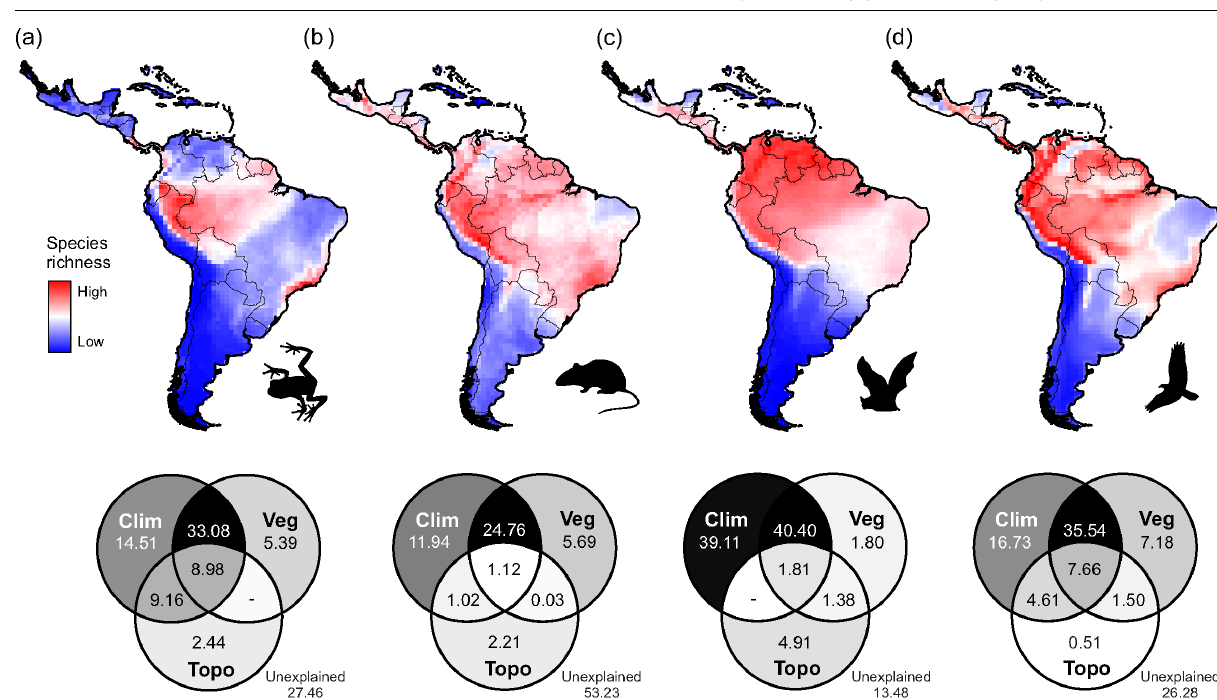
Figure 1. Patterns of Neotropical species richness for (a) amphibians, (b) non-volant mammals, (c) bats, and (d) birds. The Venn diagrams at the bottom show the variation partitioning of species richness according to gradients related to climate (Clim), topography (Topo), and vegetation (Veg). The light-dark colour gradient of the Venn diagrams re- presents the low-high variation explained by the predictor sets. For simplicity, the spatial predictor set is not shown in the Venn diagrams, but see Moura et al. (2016) for further